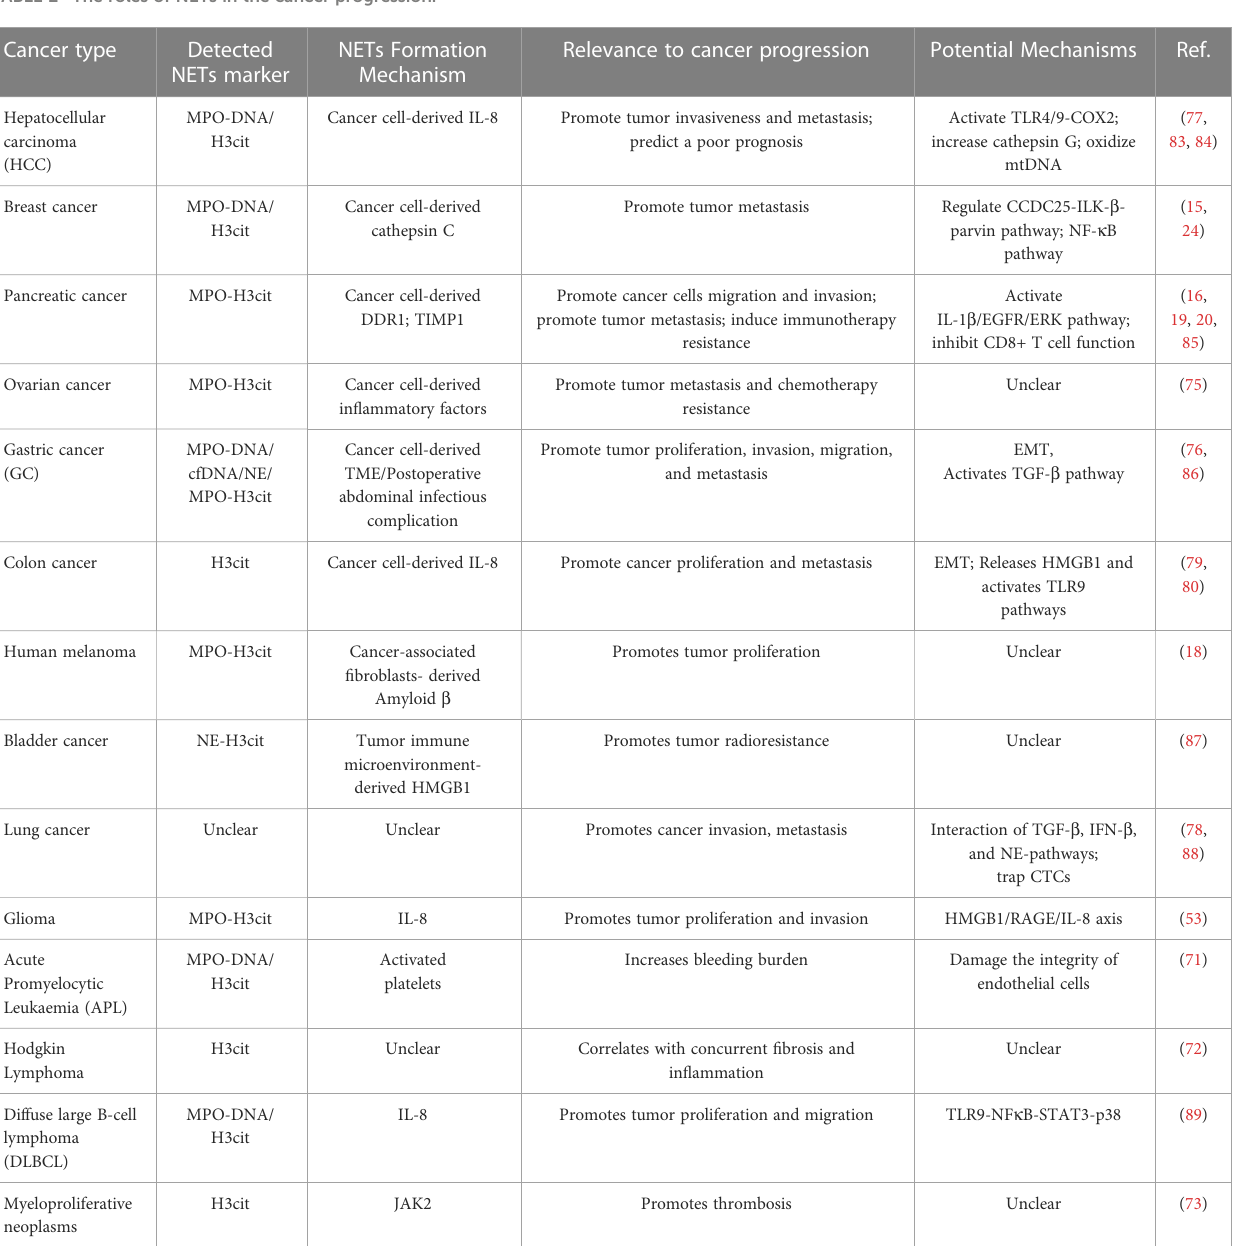
TABLE 2 The roles of NETs in the cancer